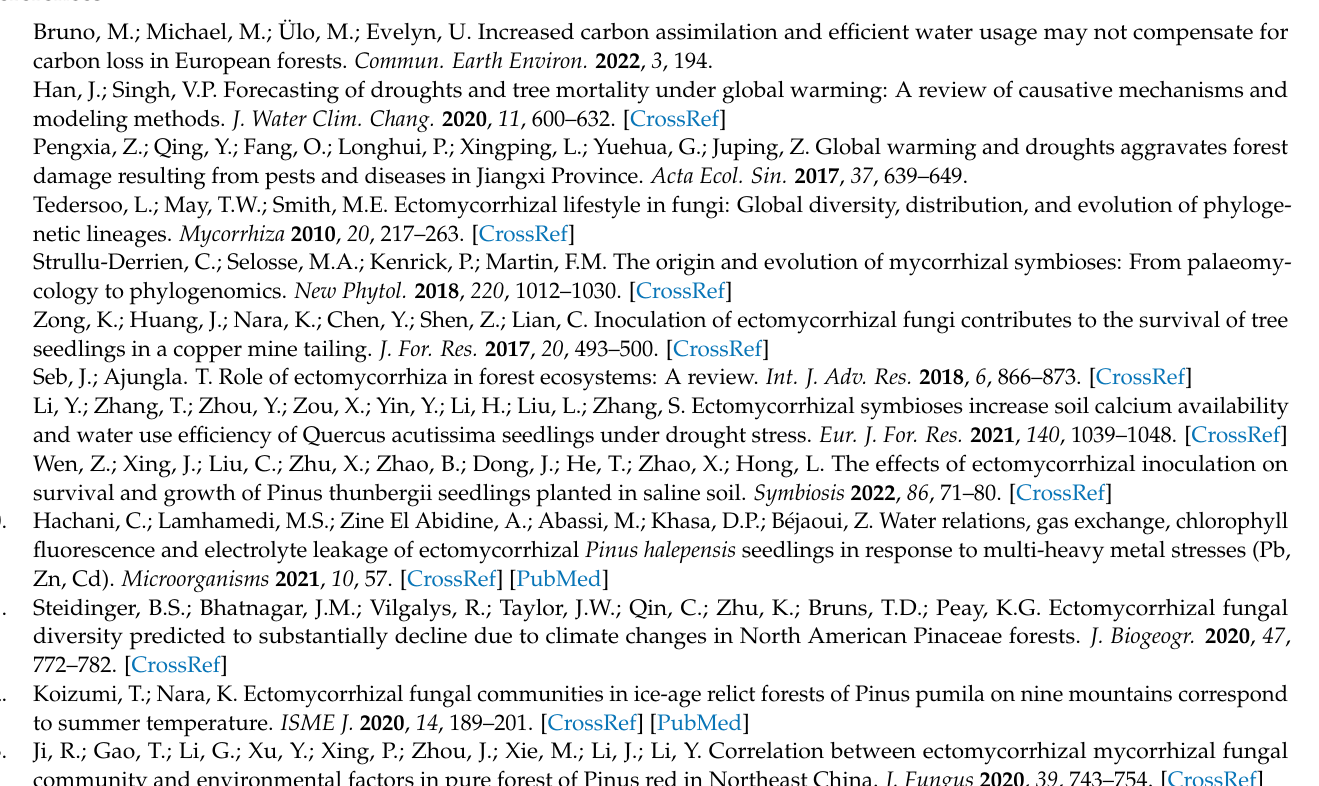
table for C. geophilum sequencing data evaluation; Table S4: The Pearson's correlation of gene expression levels between samples; Table S5: Differentially expressed genes in the significantly enriched pathway of C. geophilum in 30 °C against control; Figure S1: Gene species distribution map; Figure S2: Replicated correlation heatmap; Figure S3: Volcano plot of DEGs between tolerant and sensitive six Cenococcum geophilum isolates under temperature stress; Figure S4: Up-regulation and down-regulation of genes in Cenococcum geophilum